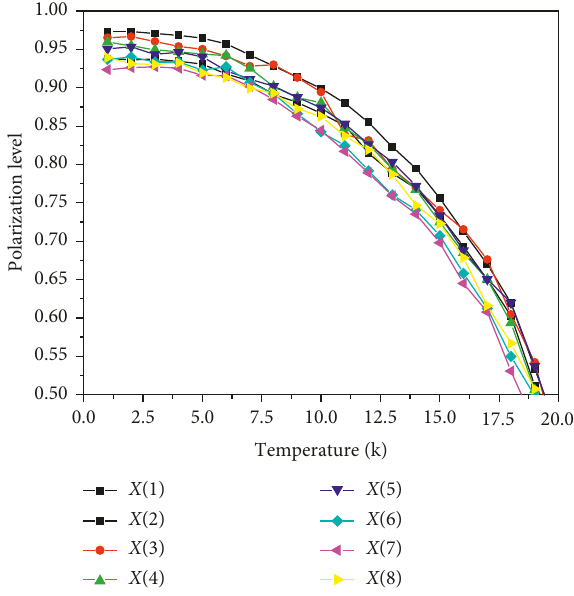
Figure 14: The effect of temperature variations on polarization of the output cell in the proposed